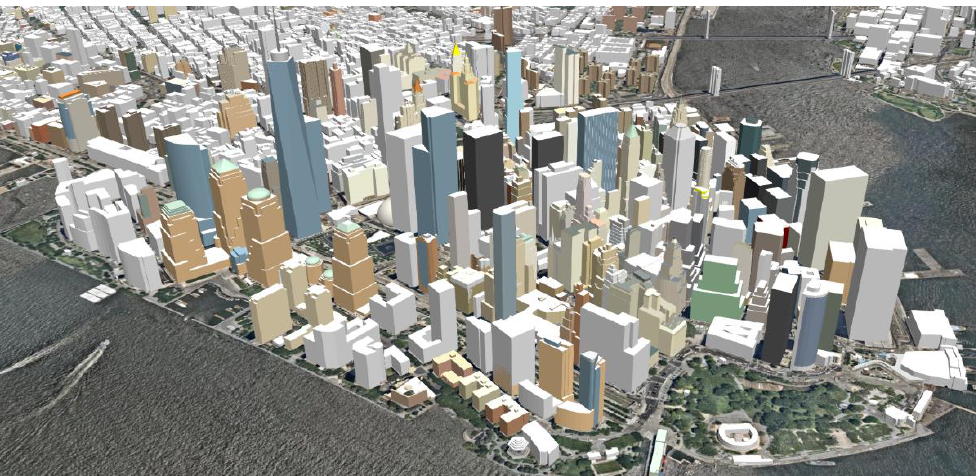
( a ) Display visualization task: City model.